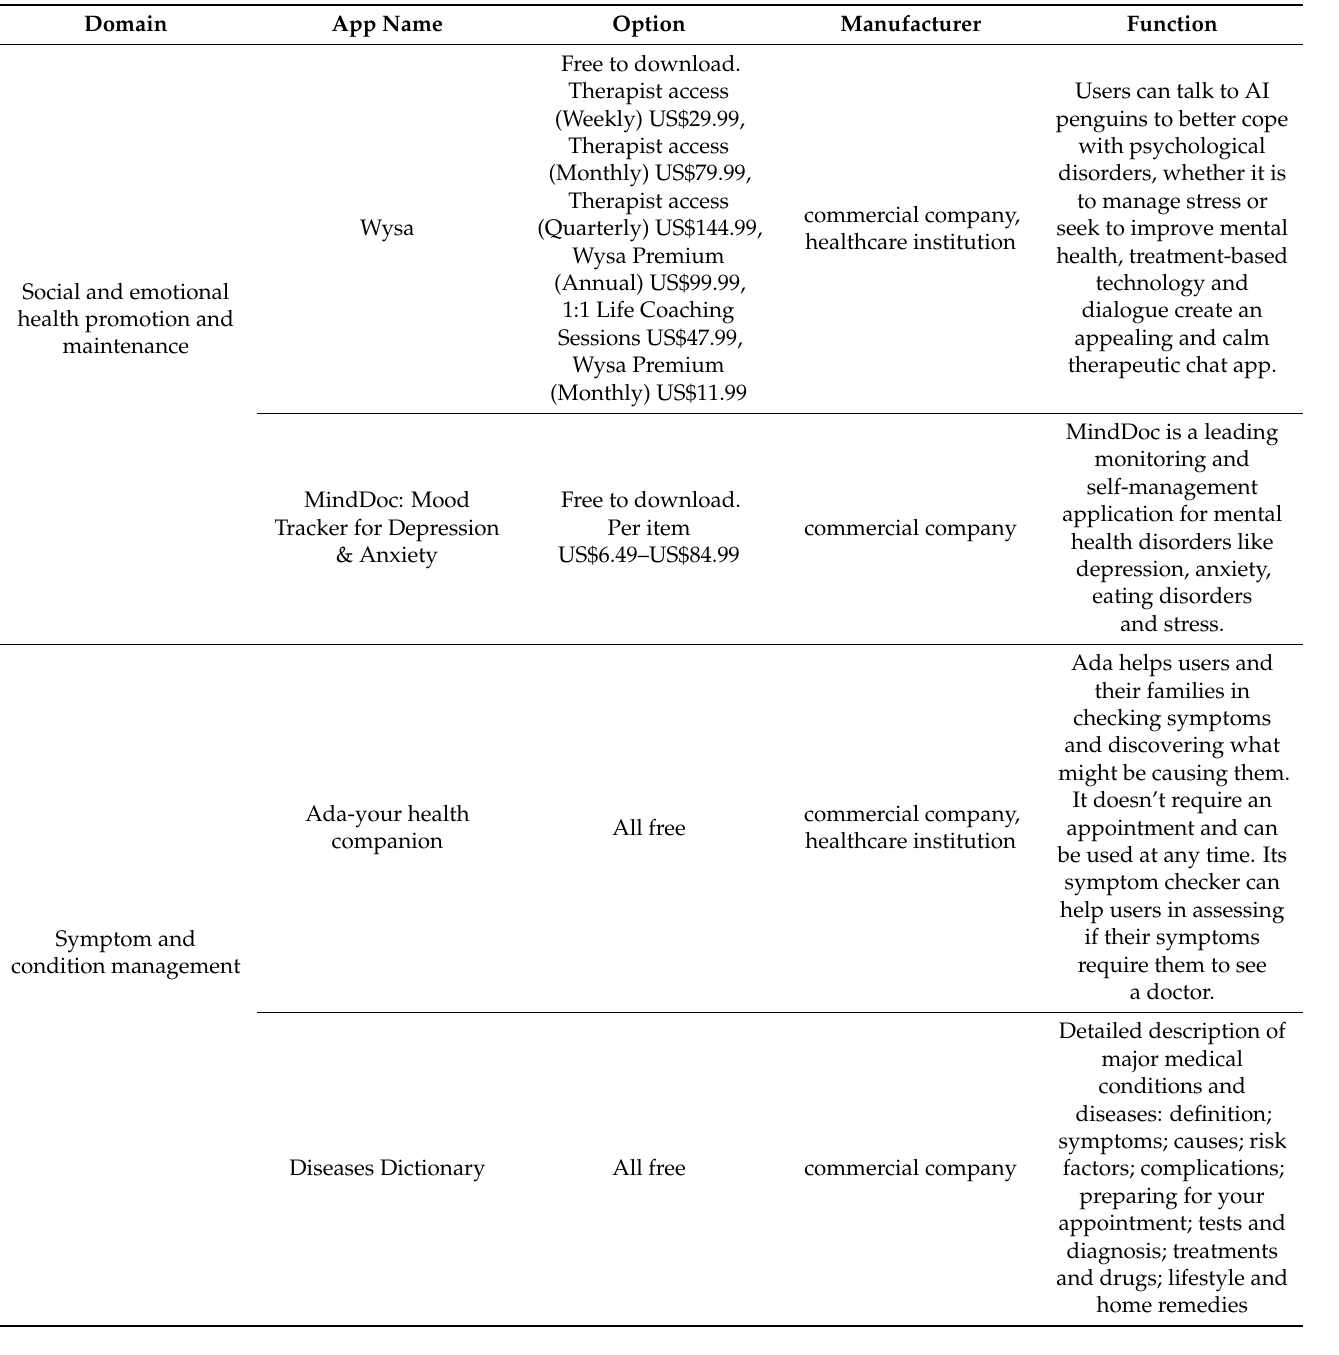
Table 1. Costs and functions of 12 smartphone applications for older adults to use daily while in isolation during the COVID-19